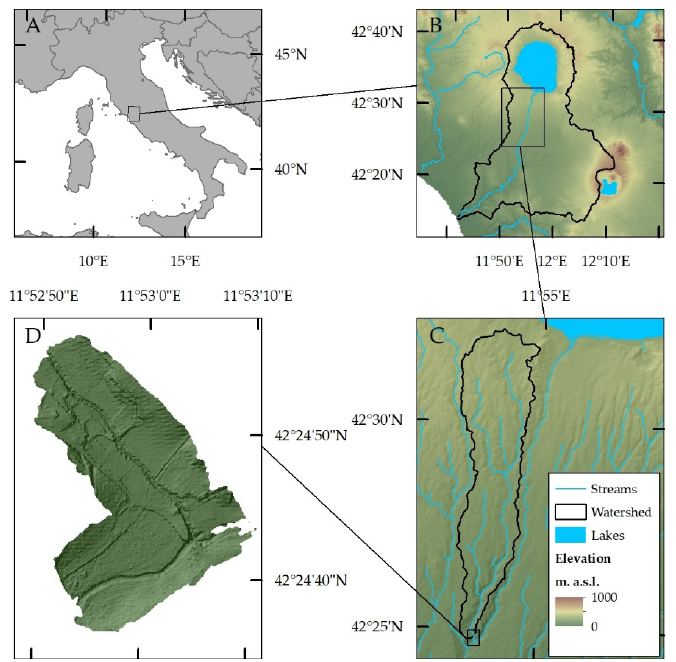
Figure 1. ( A ) Location of the Marta river basin in Central Italy. ( B ) Map of the Marta River Basin. ( C ) Watershed of the Maschiolo small tributary of the Marta river. ( D ) Map of the study area, showing the shades of the LiDAR DEM. The legend in panel C is also related to panels B and D.